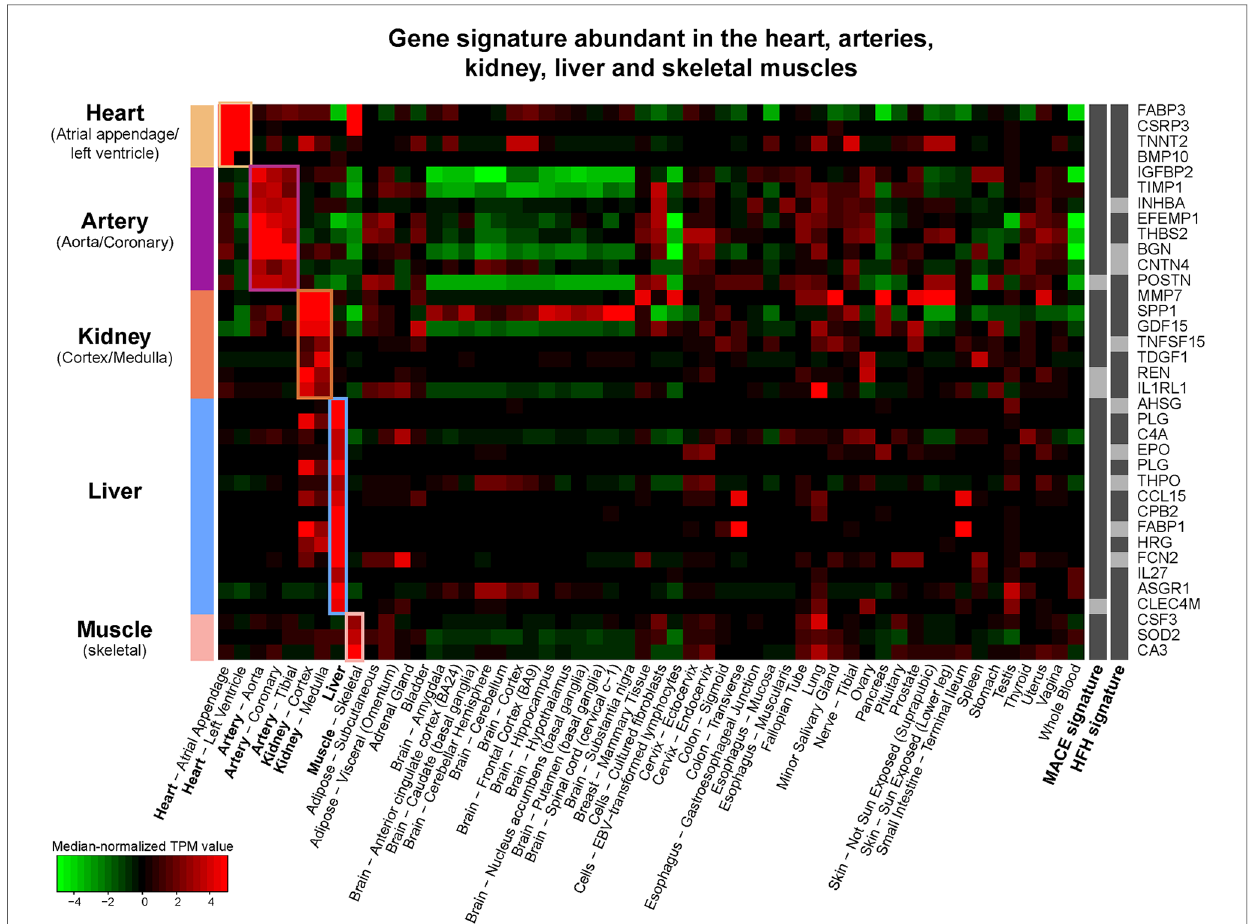
FIGURE 5 Tissue speci fi c gene expression (median-normalized TPM values) of 36 plasma proteins in the MACE and HF signatures with speci fi c enrichment in heart, arteries, kidneys, liver, and skeletal muscle according to the GTEx